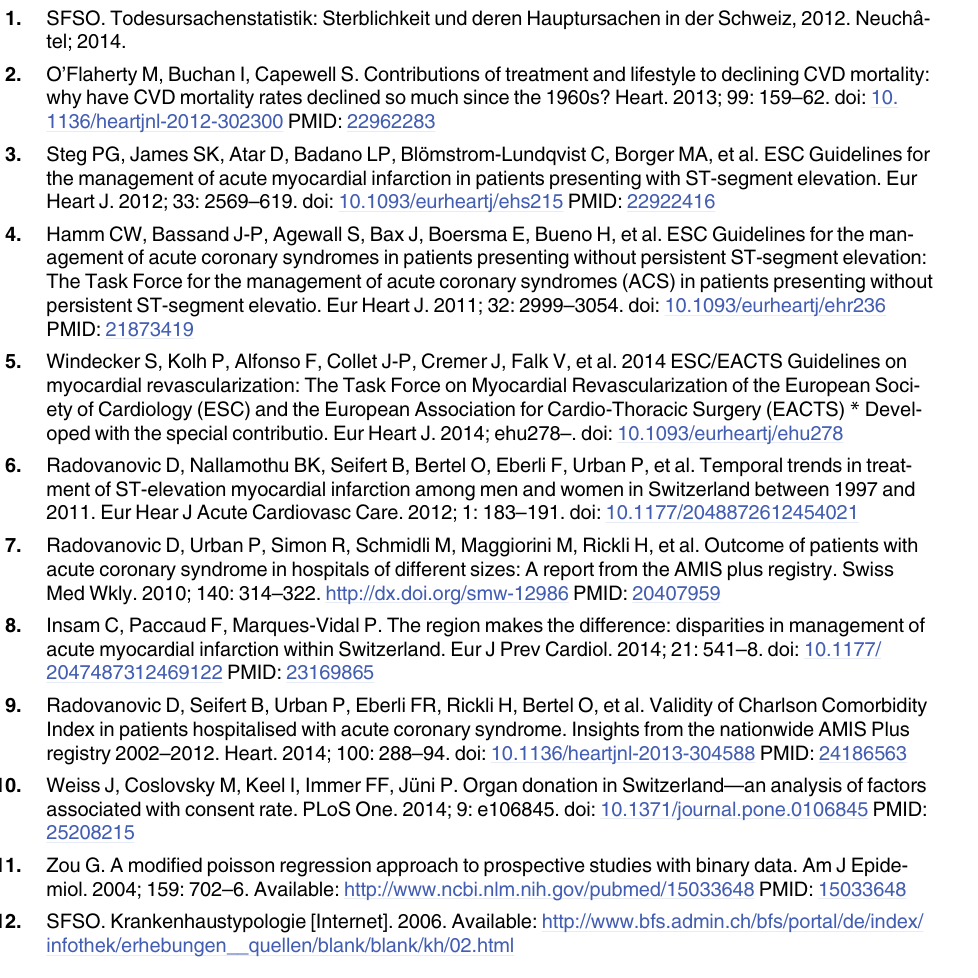
S6 Table. Results of the multilevel Poisson regression for revascularization for male and female patients 65 years and